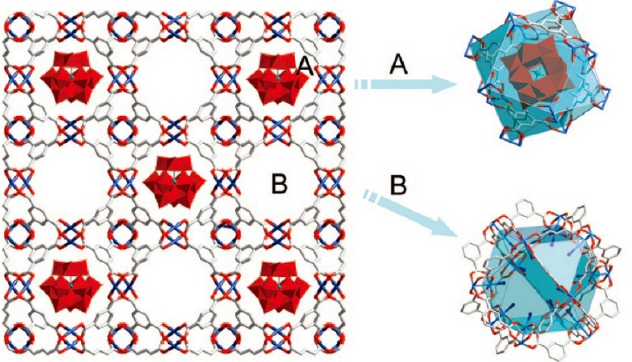
Figure 3. Polyhedral and ball-and-stick representation of NENU - 3 Colour code: Blue, Cu; red, O; gray, C. Reproduced with permission from ACS, 2009